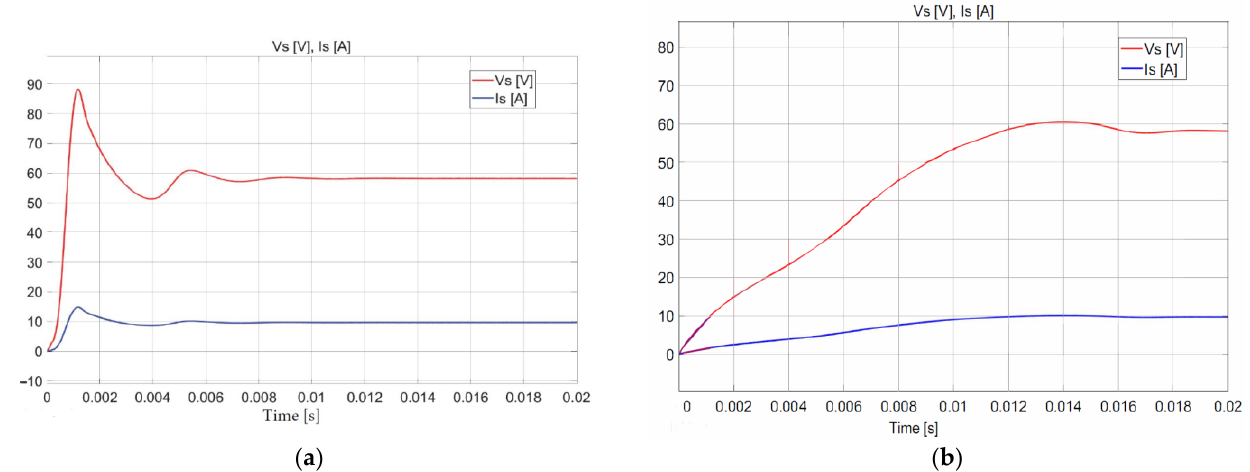
Figure 12. Values of 𝑉 𝑠 in volts & 𝐼 𝑠 in amperes : ( a ) without soft-start algorithm integrated; ( b ) with soft-start algorithm integrated.